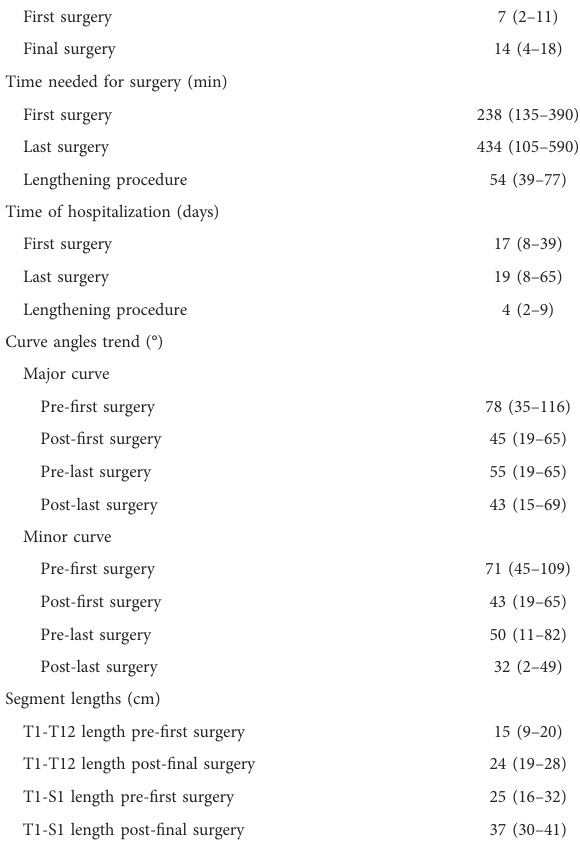
TABLE 1 Results in our 40-patient